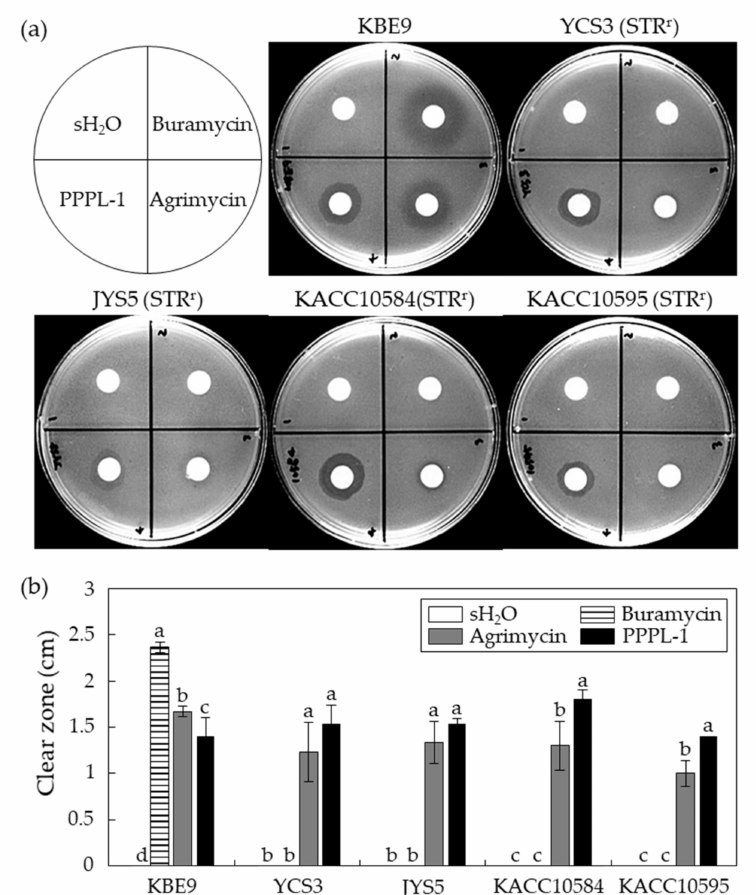
Figure 4. Antibacterial effects of PPPL-1 on streptomycin-resistant Psa isolates. ( a ) The images of plates showing clear zones. The most top left figure showed the treatment of other figures. ( b ) Length of clear zone caused by each treatment. The error bars indicate the standard deviation ( n = 3), and the alphabets on top of each bar indicate the different groups based on significant differences at p < 0.05 by Duncan’s multiple range test in each strain. sH 2 O, sterilized water; Buramycin™ (1.25 g/L); Agrimycin™ (0.4 g/L); PPPL-1 (10 8